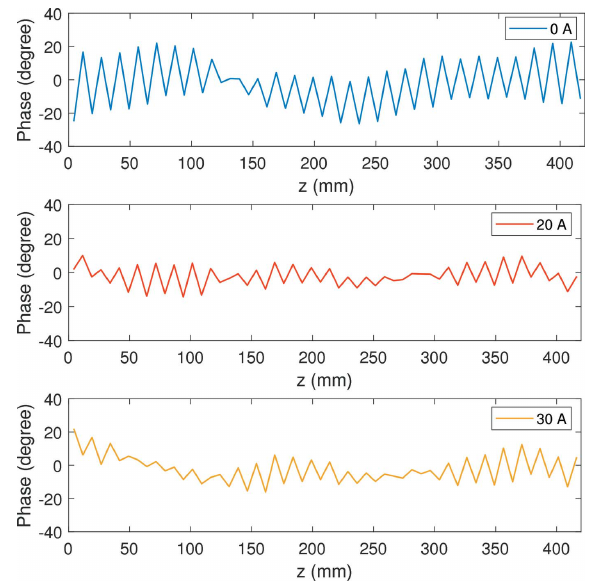
Figure 14 Phase maps with 400 main current and 0 A (top), 20 A (middle), 30 A (bottom) correction currents.